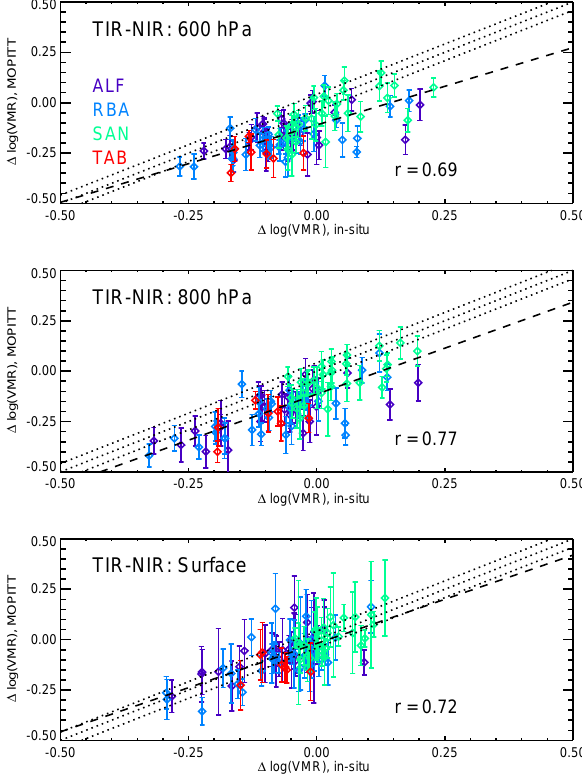
Figure 6. MOPITT Version 6 TIR-only validation results (as pre- sented in Fig. 4), with a priori influence removed from both the MO- PITT retrieved values and simulated retrievals based on the in situ data. As discussed in Sect. 3.2.3, plotted values correspond to the difference of retrieved (or simulated) log(VMR) values and the a priori log(VMR) value.